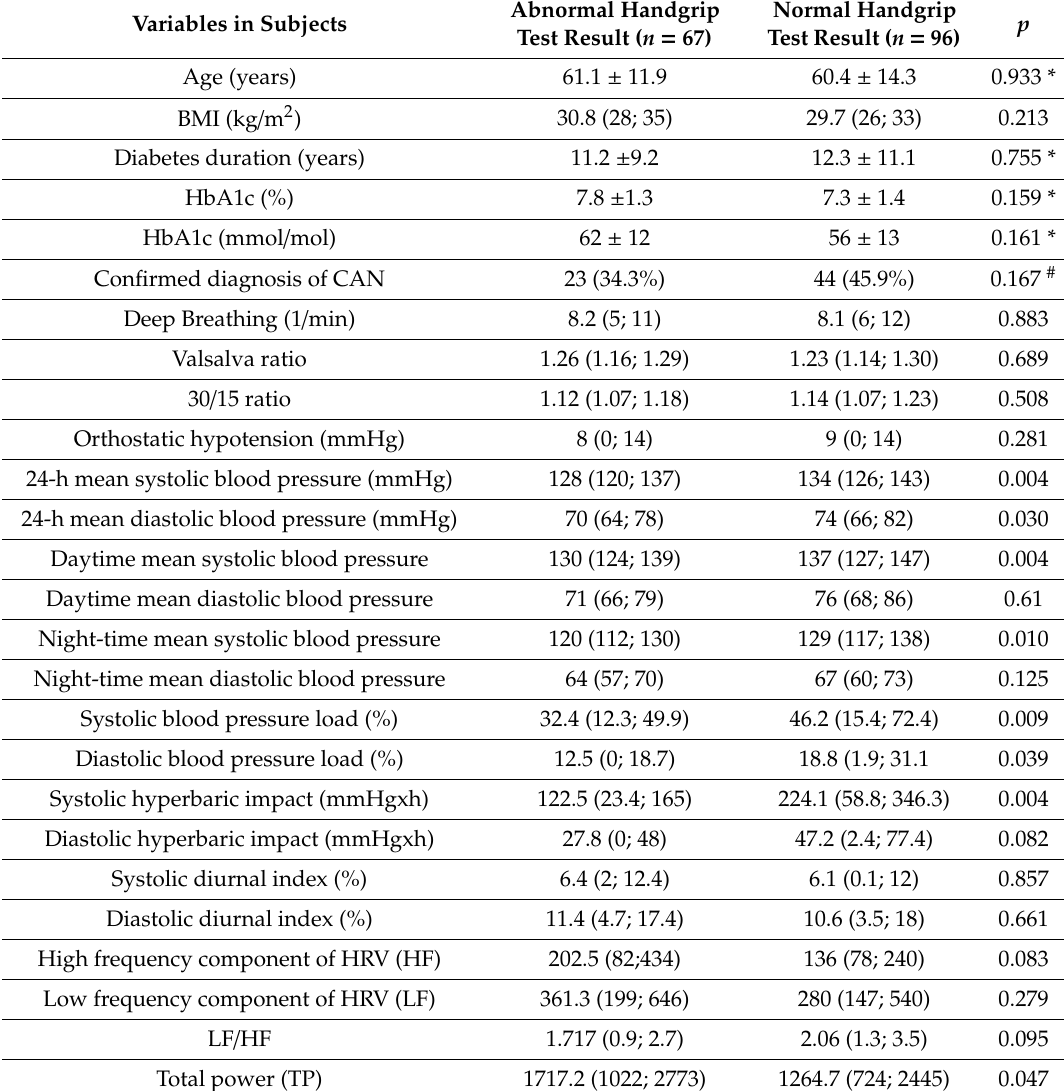
Table 2. Comparison of variables between diabetic subjects with and without handgrip test abnormality (univariate